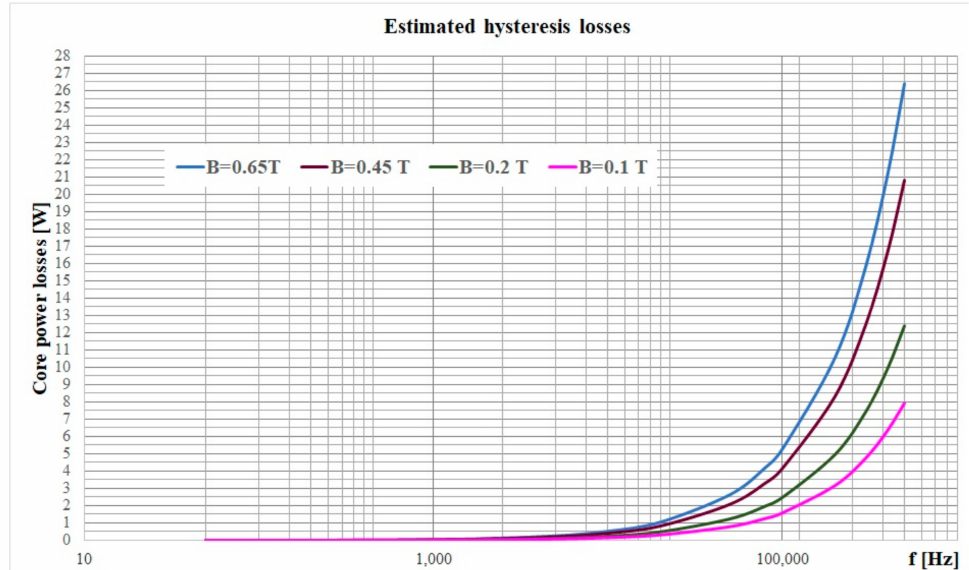
Figure 8. The estimated hysteresis losses for di ff erent flux densities of the investigated